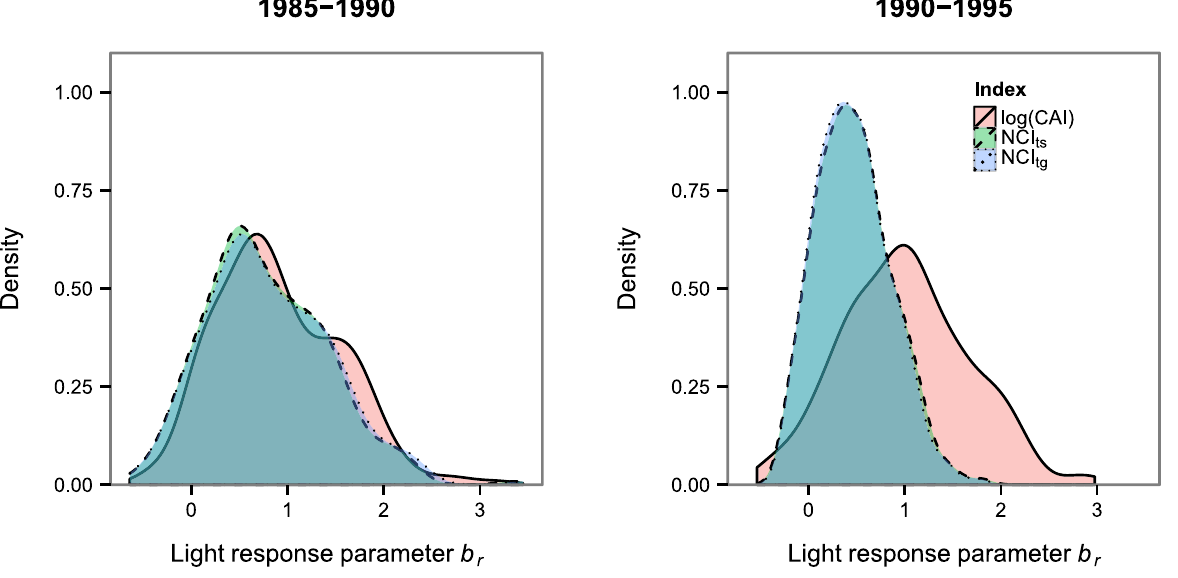
Figure 4. Community-wide distribution of the light response of recruitment ( b r ). Light is estimated either with the canopy index (log(CAI)), the interval-specific neighbordood competition index (NCI ts) or the general neighborhood competition index (NCI tg ). The underlying histogram can lead to sharp edges of the density plot.